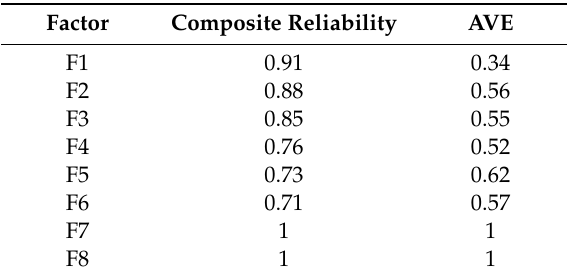
Table 1. Composite reliability and average variance extracted values of each factor.